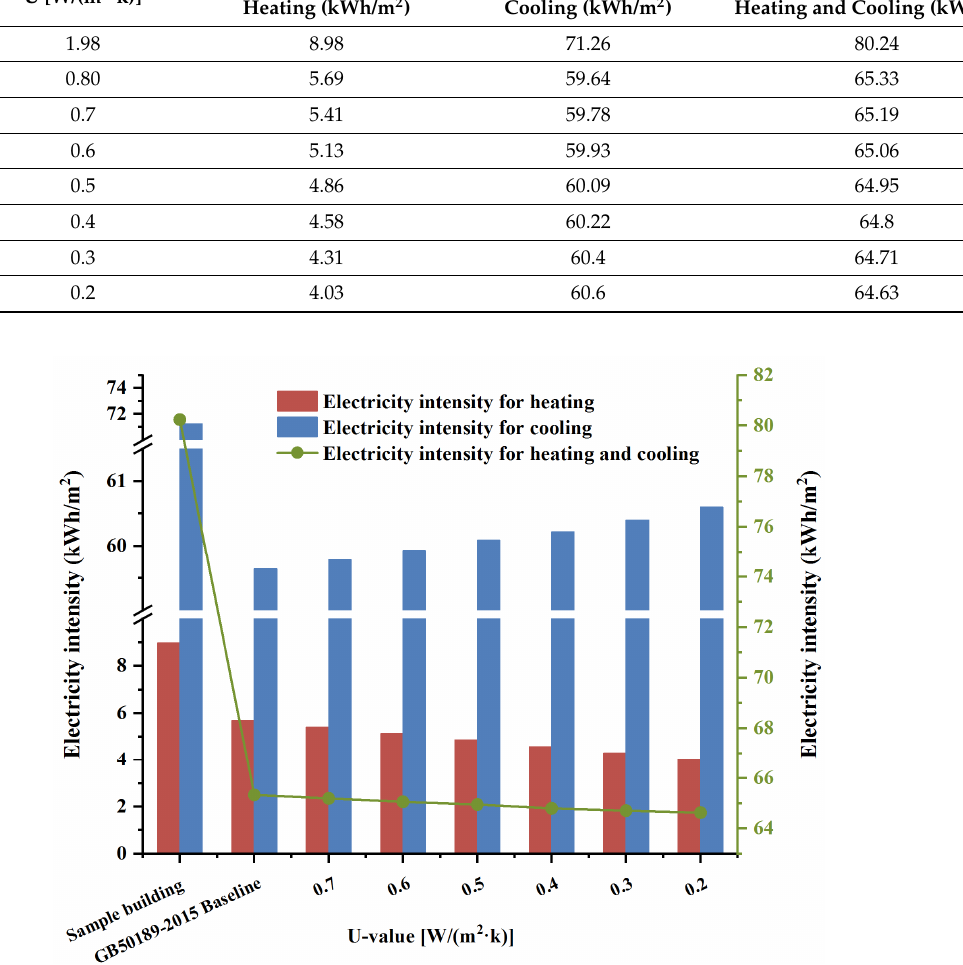
Table 6. Energy simulation results of using different U-values for external wall energy retrofitting.